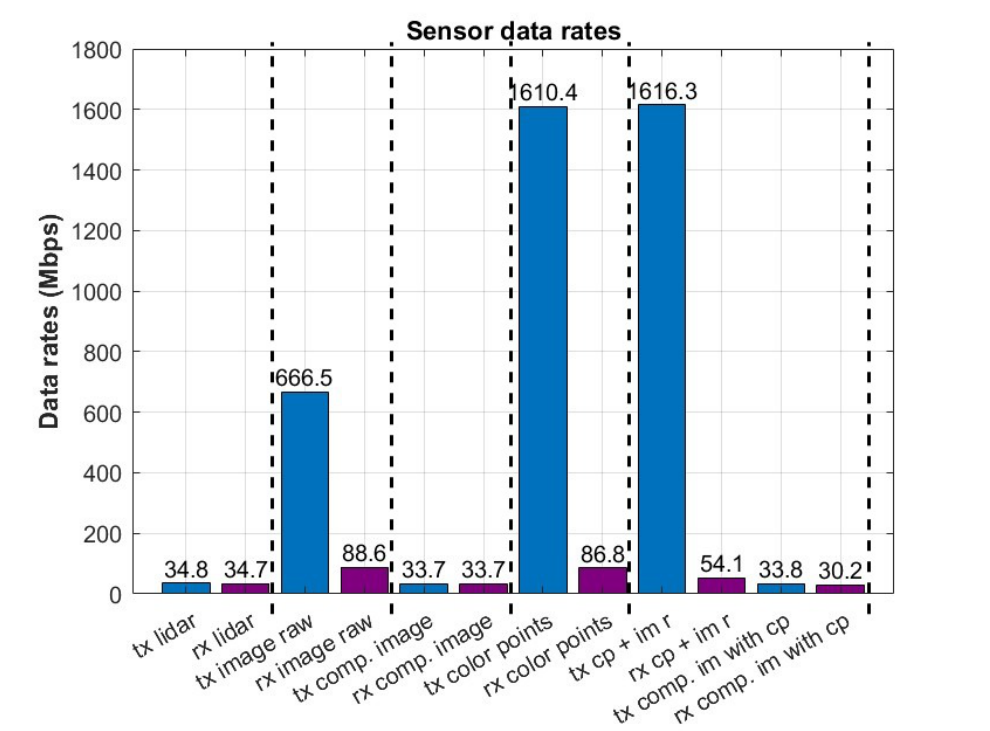
Figure 3. UAV streaming sensors over the 5G cellular